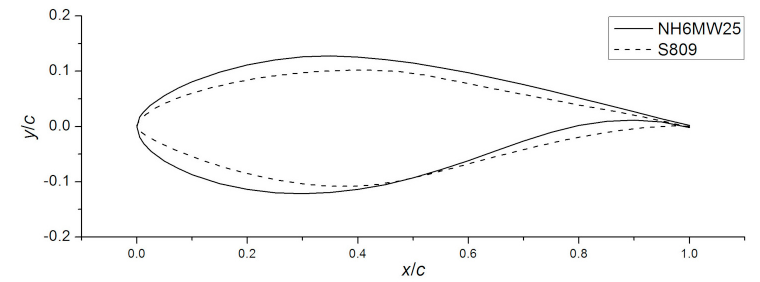
Figure 13. Configurations of NH6MW25 and S809 airfoils.